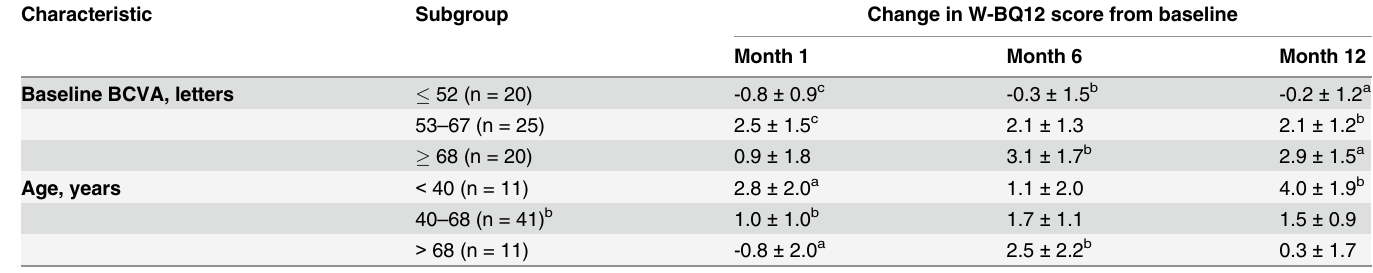
Table 3. W-BQ12 results according to baseline BCVA and age.